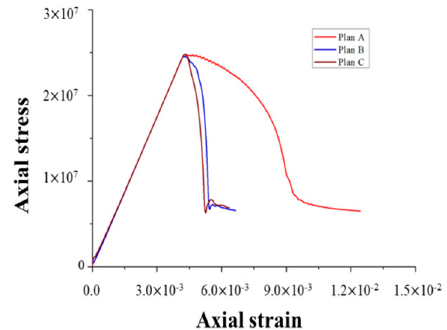
Figure 9. Comparison of numerical simulation results under different cell mesh sizes.